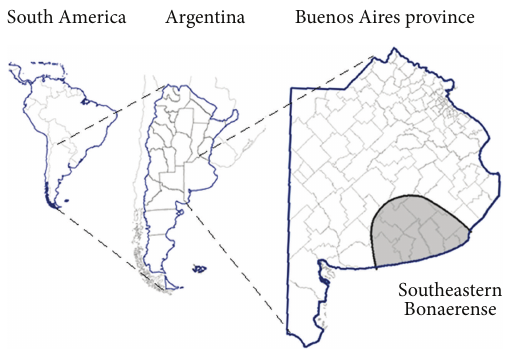
Figure 1: Map of South America indicating Argentina and the shadow area that comprises the Southeastern Buenos